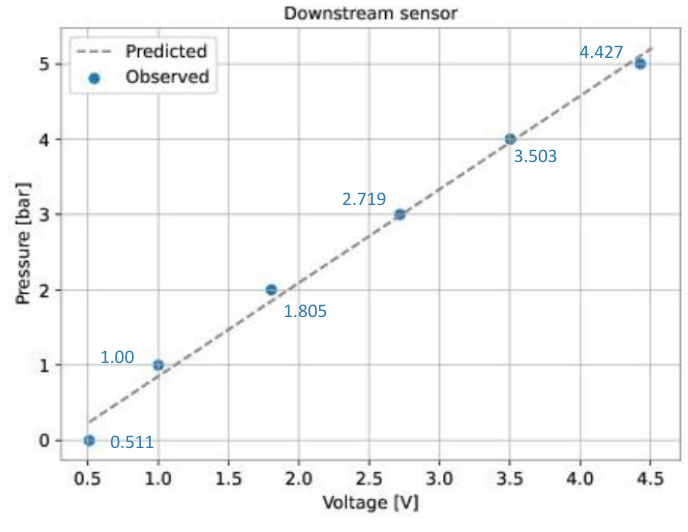
Figure 27. Curve-fitting for the pressure sensors. Downstream sensor.